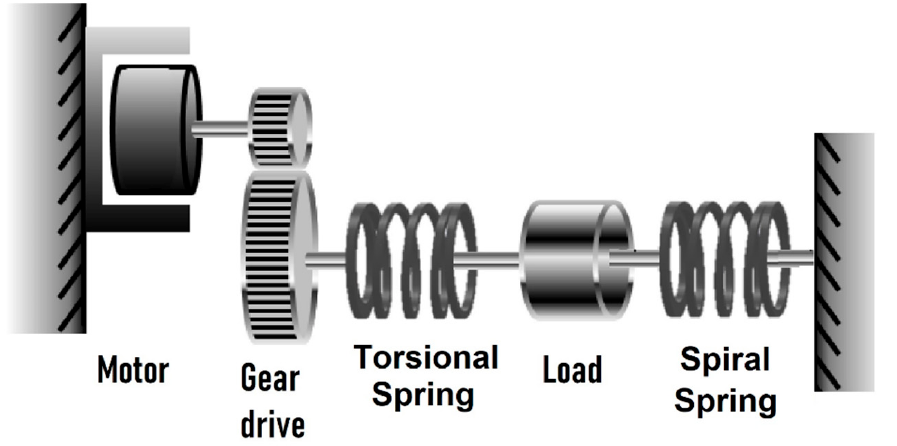
Figure 4. ES-RSEA Figure 4. ES ‐ RSEA configuration.